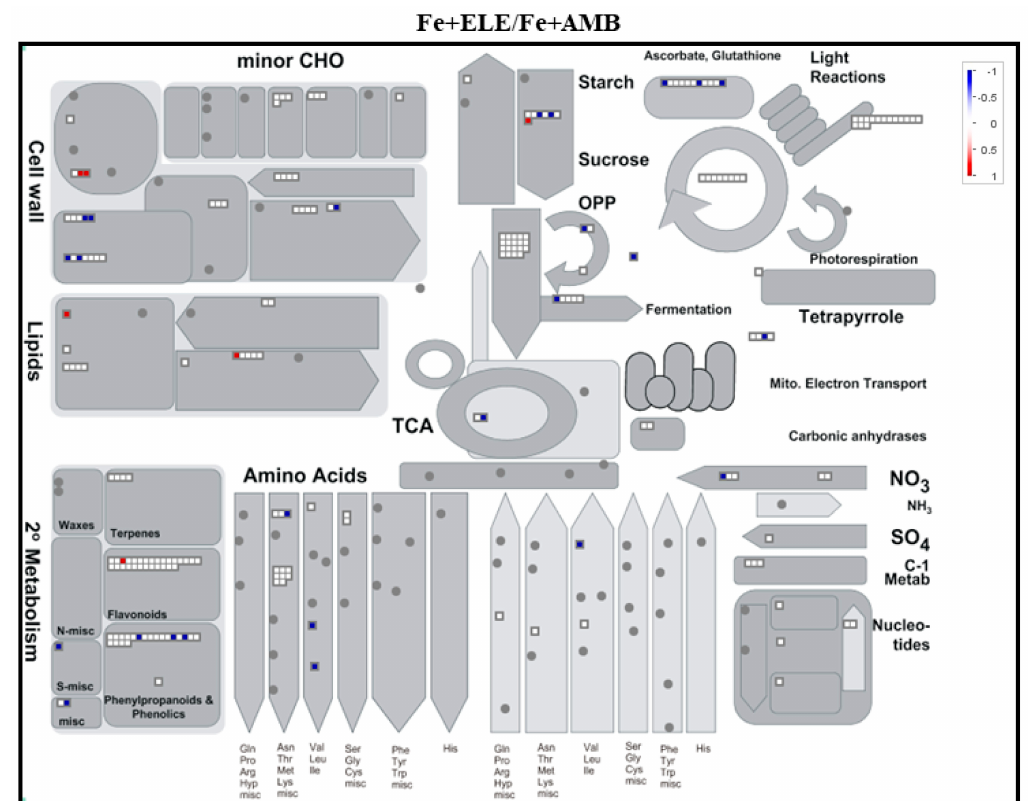
Figure 1. Soybean root proteome profiles under eCO 2 and Fe-limitation. ( A ) The number of upregulated and downregulated proteins in soybean root in response to eCO 2 and Fe-limitation; ( B ) Cluster analysis of all differently regulated proteins among different treatments. Fe+AMB, Fe-sufficient + aCO 2 ; Fe+ELE, Fe-sufficient + eCO 2 ; Fe-AMB, Fe-limitation + aCO 2 ; Fe-ELE, Fe-limitation + eCO 2 .